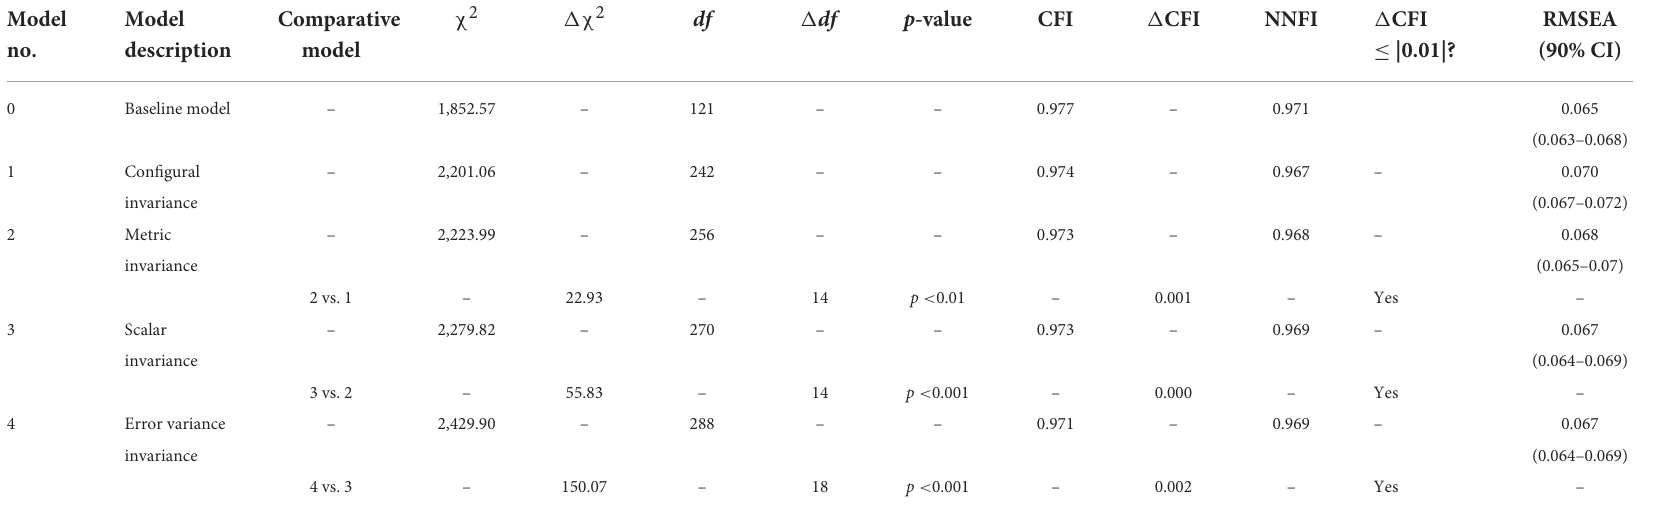
TABLE 3 Summary of goodness-of-fit for CFA and invariance tests (Multigroup comparisons by gender).